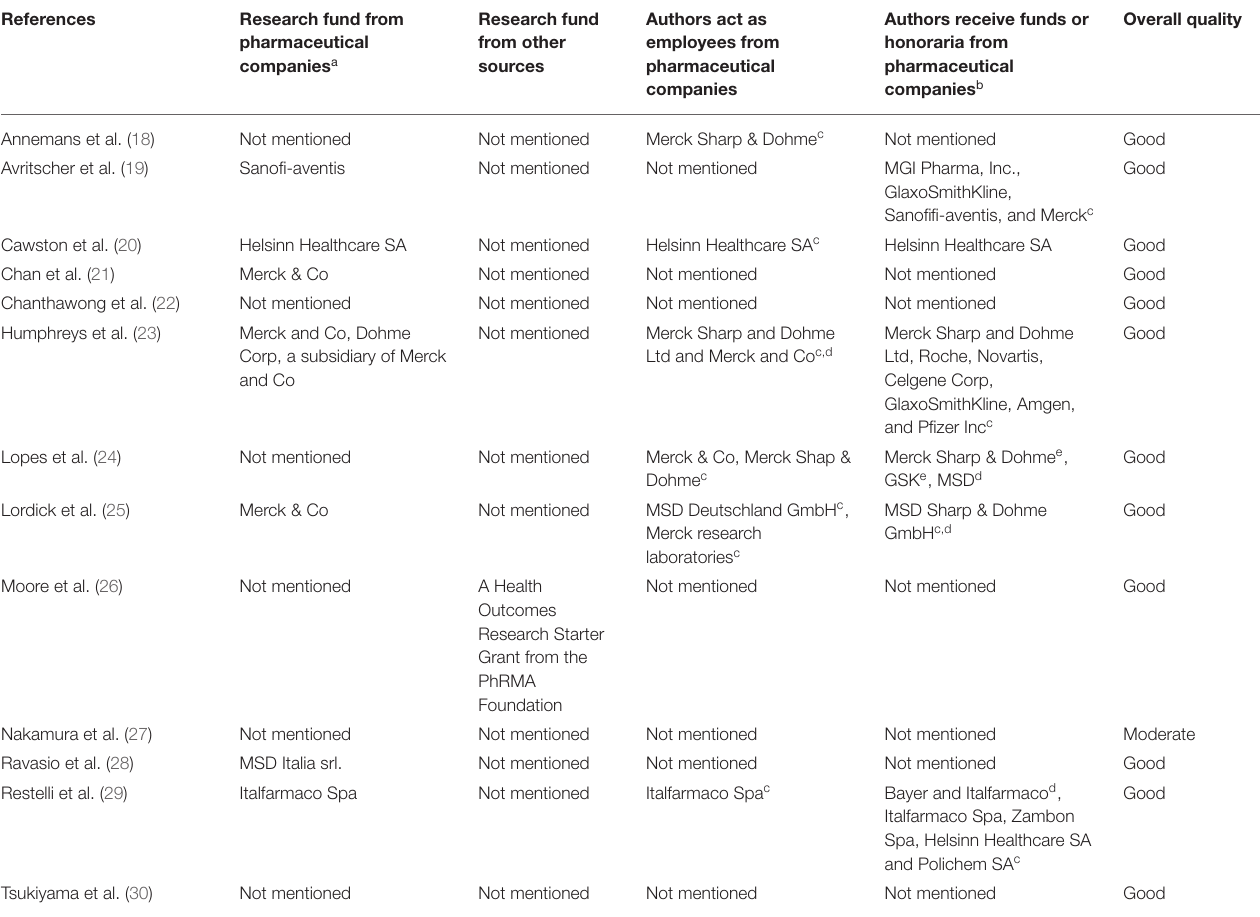
TABLE 3 | Funding information and overall quality of the economic